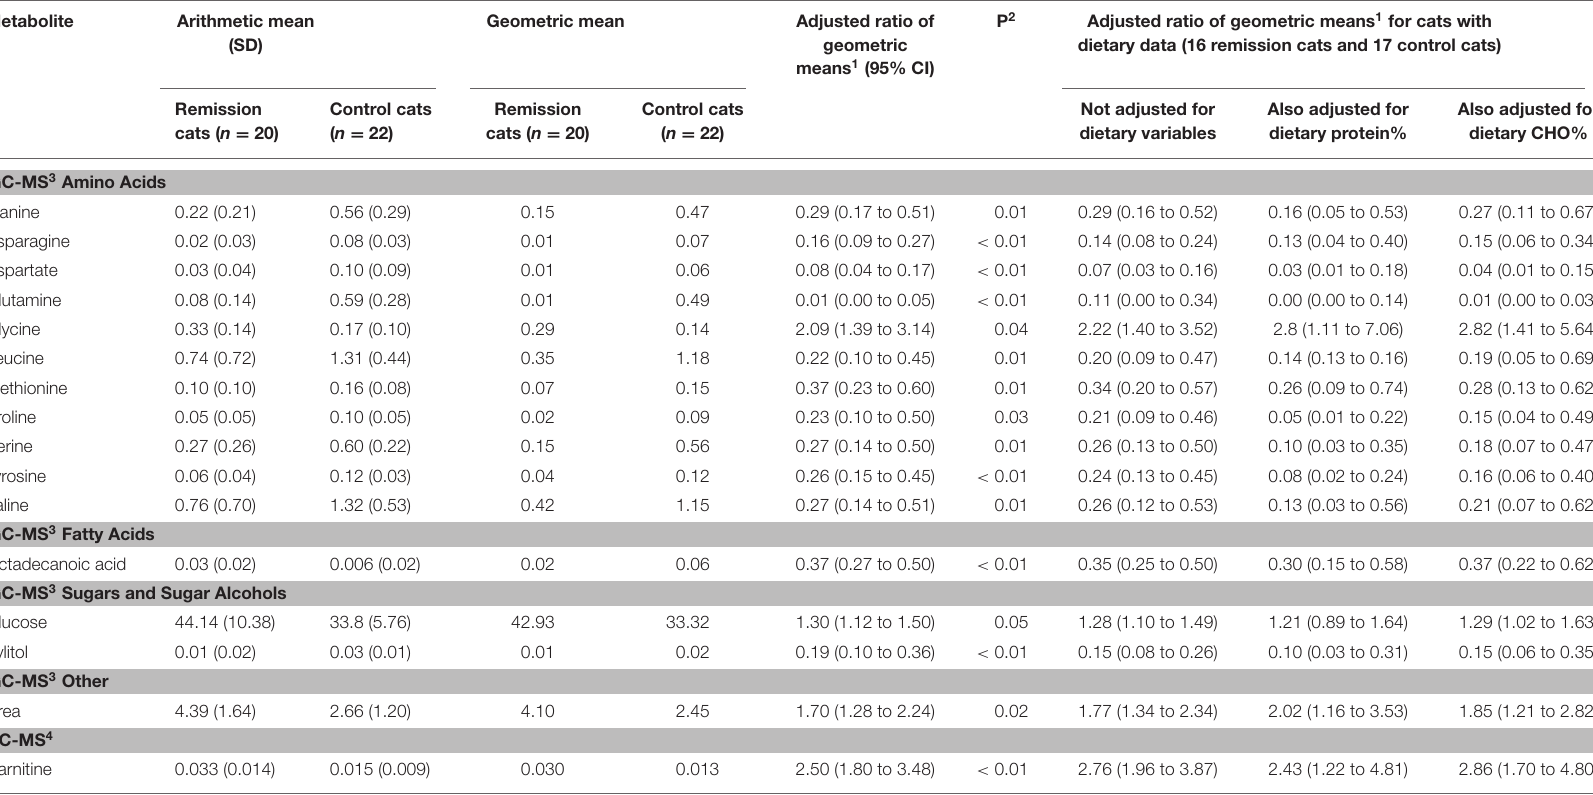
TABLE 2 | Means and estimated ratios of means for metabolites significantly different between control and remission cats ( P adjusted for multiple comparisons < 0.05). Metabolite Arithmetic mean Geometric mean Adjusted ratio of P 2 Adjusted ratio of geometric means 1 for cats with (SD) geometric dietary data (16 remission cats and 17 control means 1 (95% CI)